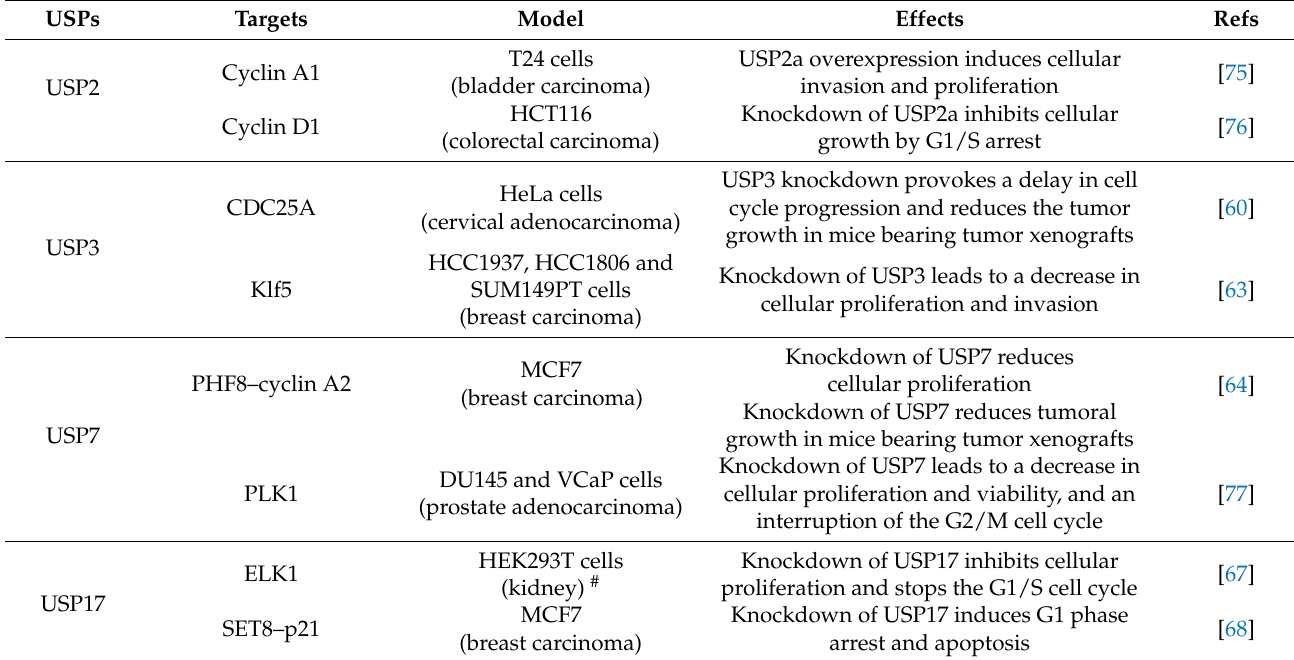
Table 1. Summary of cellular consequences resulting from interactions between different USPs and target proteins associated with cell cycle